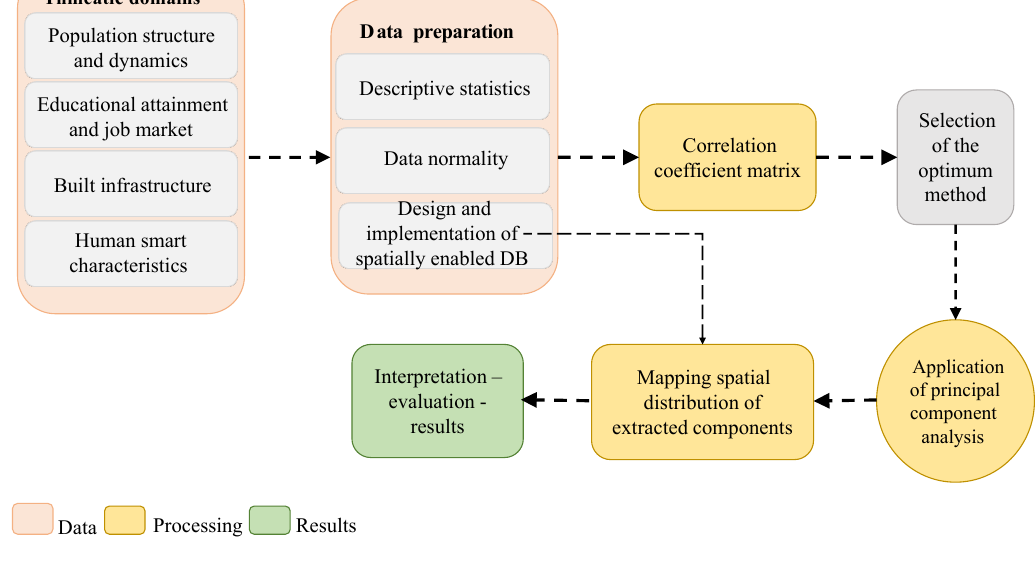
Figure 7. Overall proposed study